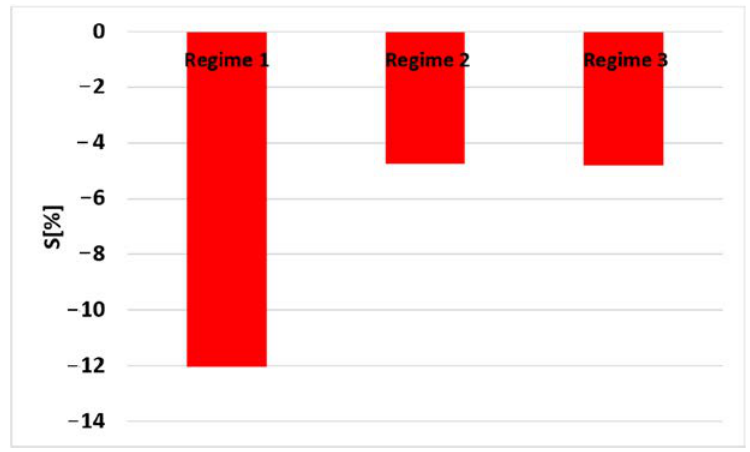
Figure 18. Variation of the specific fuel consumption depending on the regime.